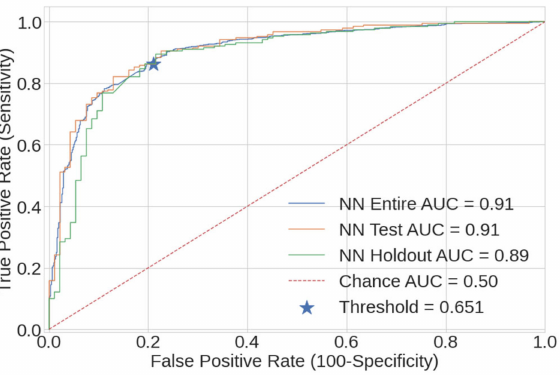
Figure 11. NN ROC curves, as measured on the entire dataset (blue), test dataset (orange) and holdout dataset (green). The selected specificity and sensitivity resulting from a threshold of 0.651 are denoted by a blue star.